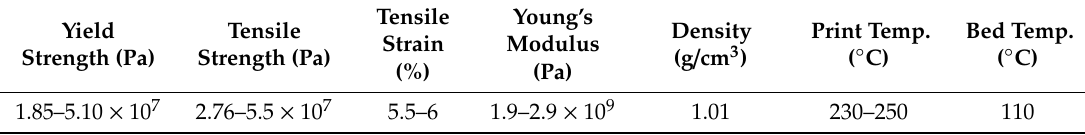
Table A2. ABS material